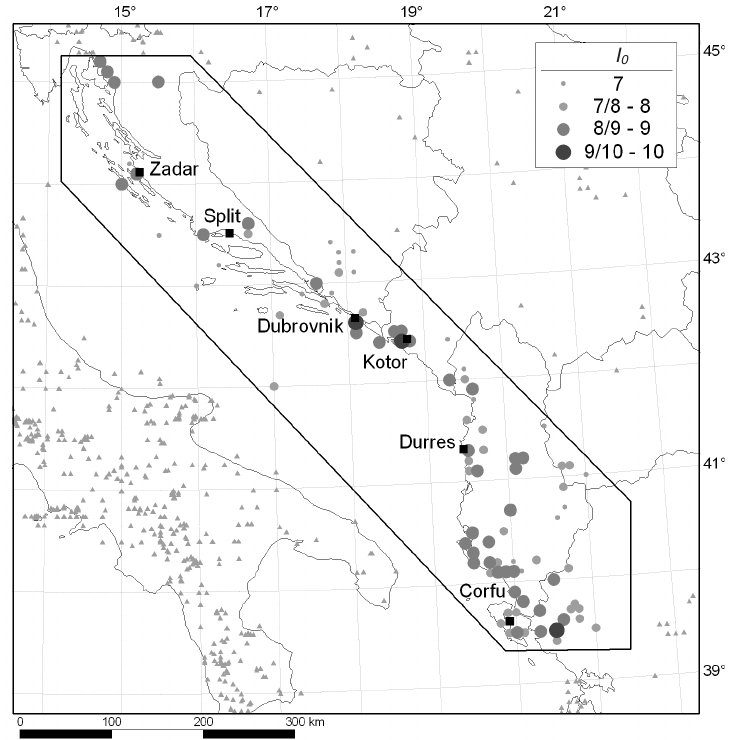
Fig. 1. Eastern Adriatic and its present geopolitical features in the background. The area of interest of this pa- per is defined by the polygon. Parameters for earthquakes between 1000 and 1899 are taken from the 1997 BEECD Working File and were chosen as the best among those supplied by the main available parametric cat- alogues for this region (see table